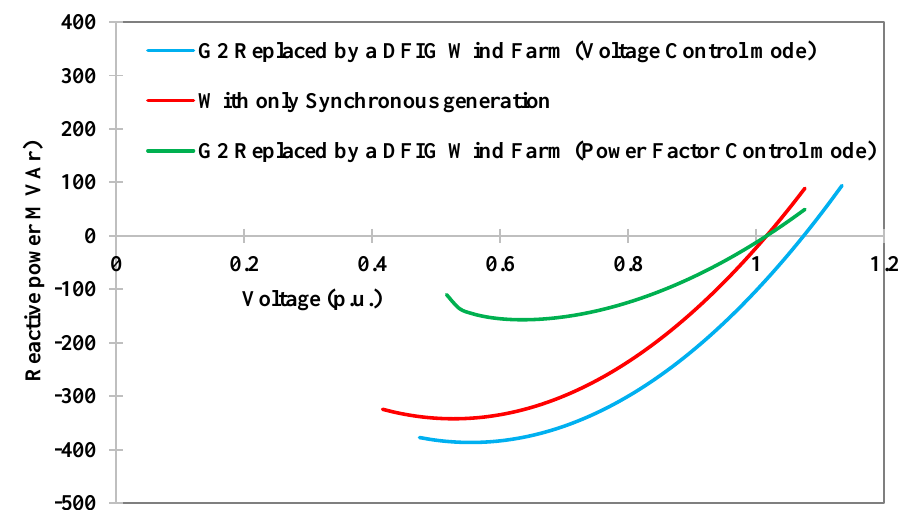
Figure 10. Q-V curves of bus-8 under three scenarios.